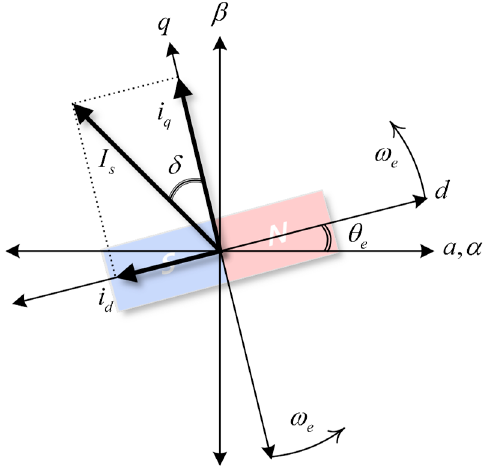
Figure 3. Stationary reference frame α − β axis and synchronous reference frame d − q axis with δ